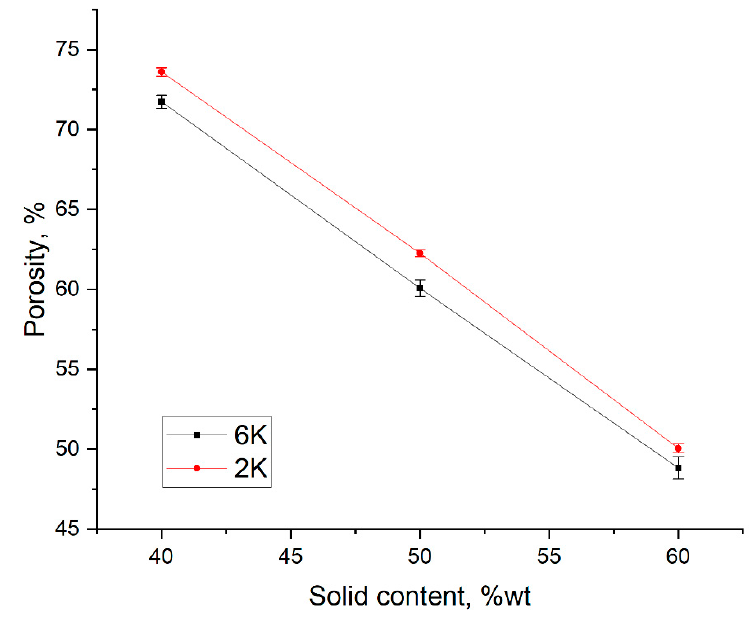
Figure 3. Influence of solid content on open porosity in specimens frozen at two different freezing rates.